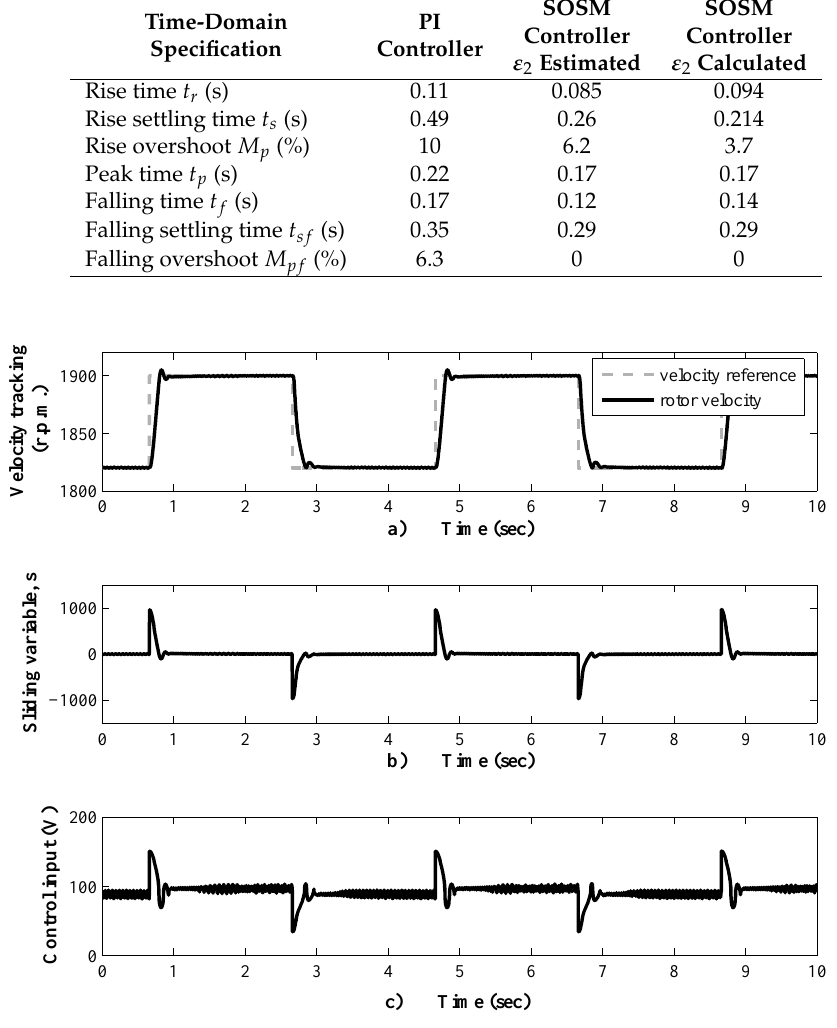
Figure 6. SOSM controller: ( a ) Velocity tracking, ( b ) sliding variable s , and ( c ) control input u a